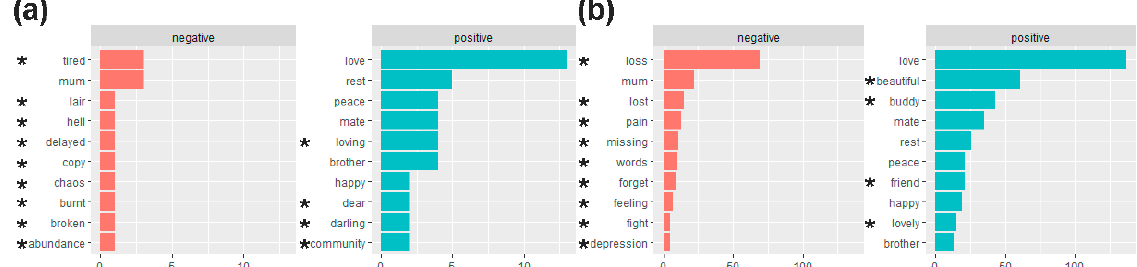
Figure 3. List of the 10 most frequent words associated with NRC lexicon sentiments in ( a ) the cluster cases and ( b ) the non-cluster controls. * the most frequent words for a sentiment for this group that do not fall among the most frequent words for the same sentiment in the other group. Words that are not marked with * are common in both groups. The frequency of words is denoted along the x -axis.